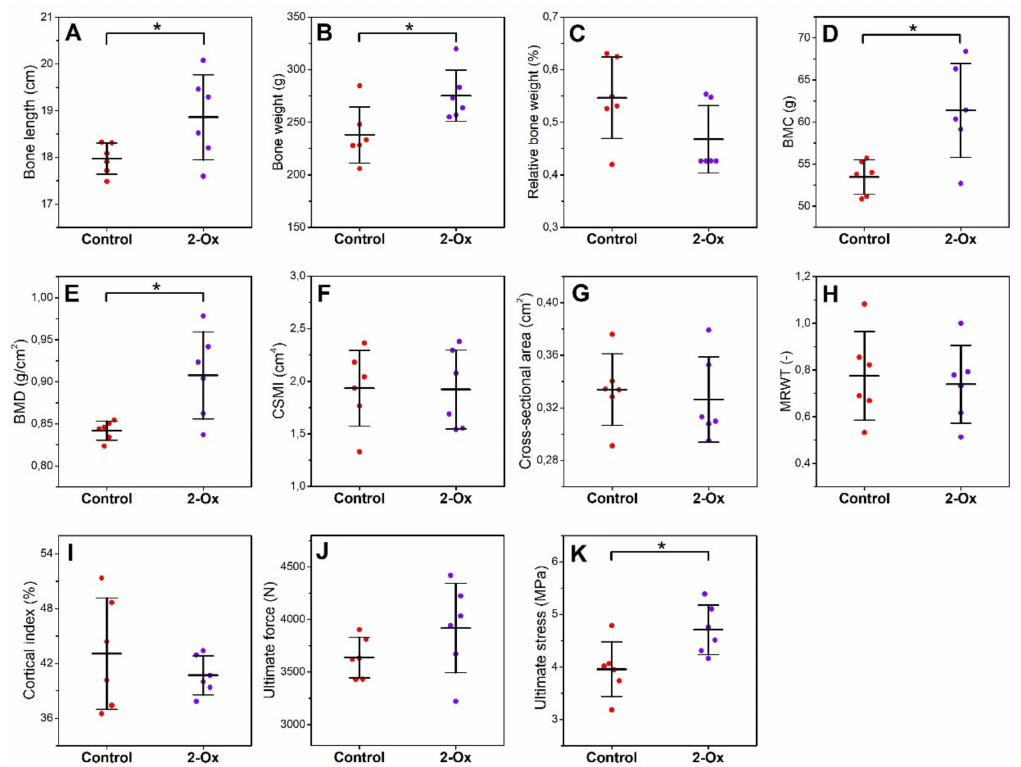
Figure 3. The e ff ect of dietary supplementation with 2-Ox on the geometric and mechanical parameters of femora from glucocorticoid-induced, growth-retarded, mature gilts: ( A ) bone length; ( B ) bone weight; ( C ) relative bone weight; ( D ) bone mineral content (BMC); ( E ) bone mineral density (BMD); ( F ) bone diaphysis cross-sectional moment of inertia (CSMI); ( G ) bone diaphysis cross-sectional area; ( H ) bone diaphysis mean relative wall thickness (MRWT); ( I ) bone diaphysis cortical index; ( J ) ultimate force; and ( K ) ultimate stress. Control—the control group included growth-retarded gilts not supplemented with 2-Ox; 2-Ox—the 2-Ox group included growth-retarded gilts supplemented with 2-Ox at a dose of 0.4 g / kg b.w. / day. Data are mean values ± SD (whiskers) from n = 6 gilts. Statistical significance: * p < 0.05; ** p < 0.01 (two-tailed Student’s t -test or Mann–Whitney U